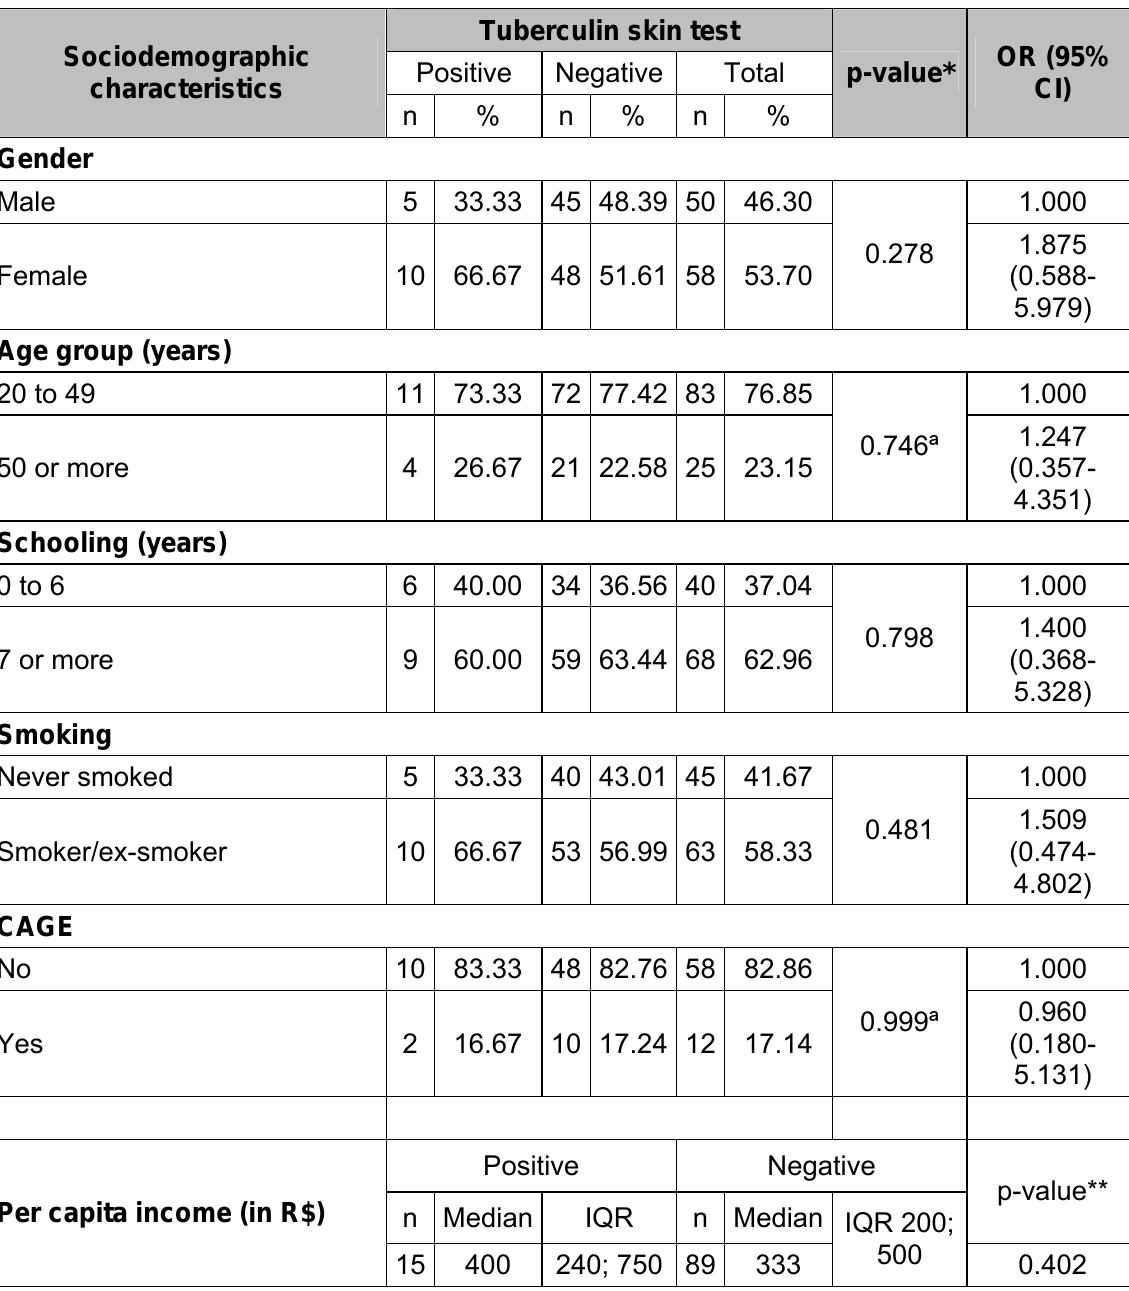
Table 1. Sociodemographic characteristics and results of the tuberculin skin test of HIV/AIDS patients in Campo Grande, Mato Grosso do Sul state, Brazil,